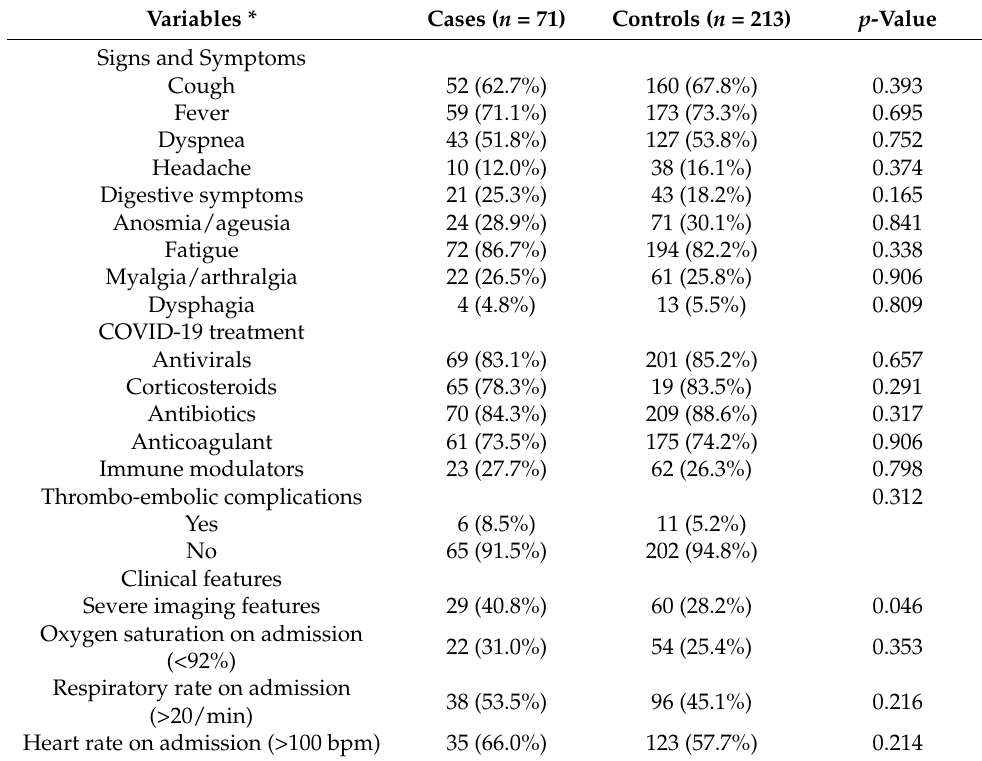
Table 2. Comparison of SARS-CoV-2 infection signs, symptoms, and outcomes between patients of cases and controls admitted to the